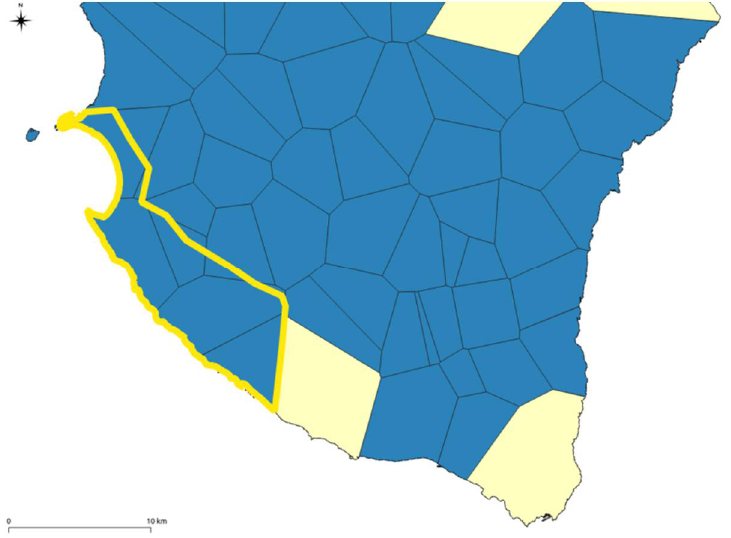
Figure 7. Example of simplification resulted by the selected geometries of Figure 6.